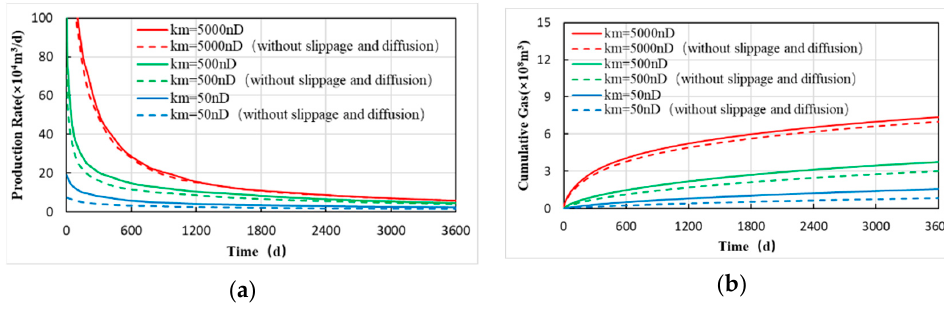
Figure 11. The effect of Knudsen diffusion and the Klinkenberg effect on productivity. ( a ) Production rate at different matrix permeability; ( b ) Cumulative gas at different matrix permeability.